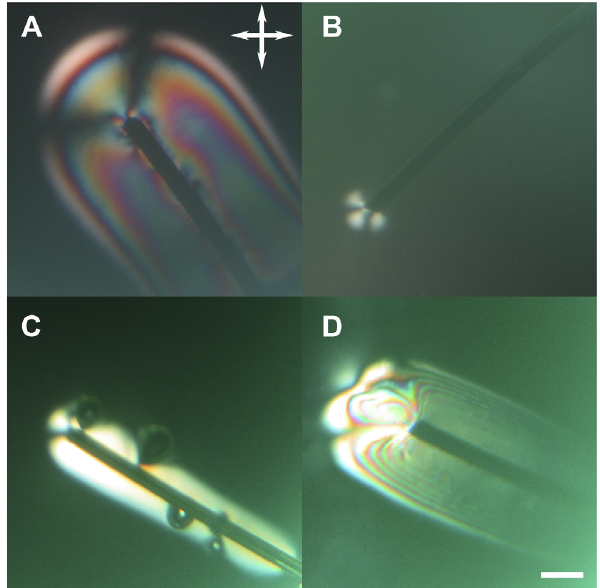
Figure 1. Optical images with crossed polarizers of four different metal wires immersed in a drop of 5.5wt% CNCs in water. Each wire was held at a constant positive potential with respect to a bundle of silver plated wires not shown in the field of view. A) Copper wire held at 1 V for 10 min. B) Iron wire held at 1 V for 7 min. C) Gold wire held at 2 V for 1 min. D) Silver wire held at 5 V for 30 s. The position of the crossed polarizers is drawn in panel A. The scale bar is 300 m